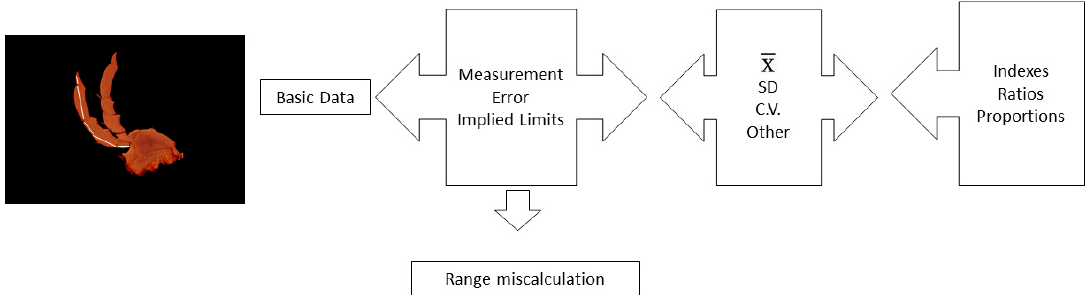
Figure 1. Workflow that moves from the basic (direct) measurement data to the calculation of their implied range and statistical derivatives.